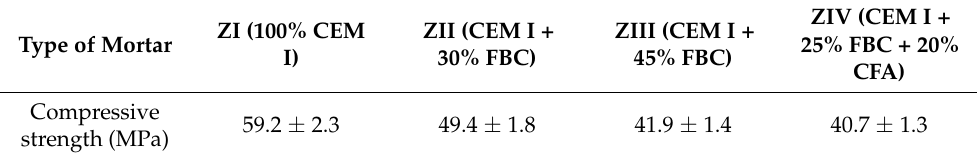
Figure 10. Compressive strength of mortars cured in 5% solution of hydrochloric acid with pH = 0.7 for 730 days. Table 8. Compressive strength of mortars cured in water after 28 days